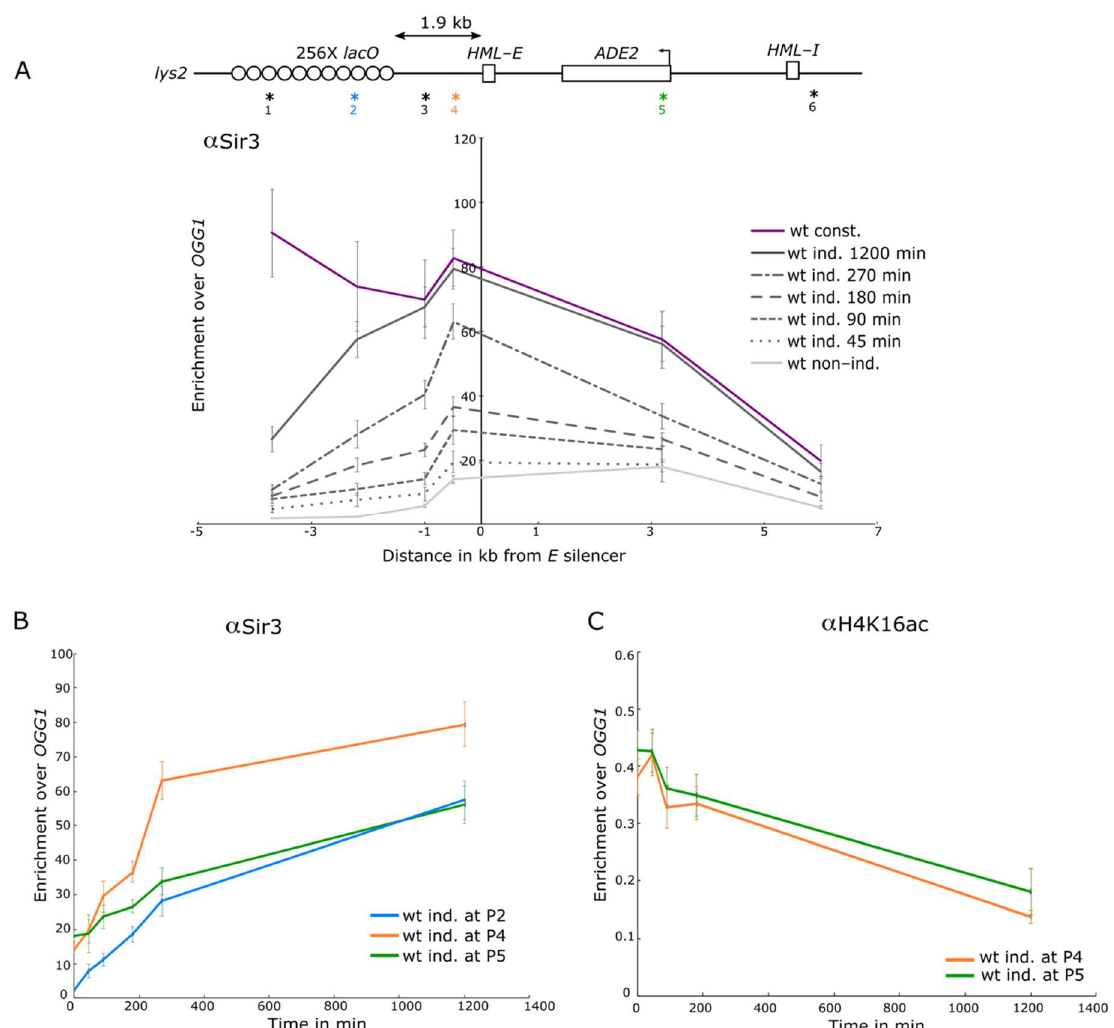
Figure 3. Heterochromatin formation takes place over several cell cycles. ( A ) Sir3 occupancy along the of lys2::lacO E-ADE2-I locus, probed by ChIP-qPCR using an anti-Sir3 antibody developed by us (Ruault et al., 2011), in strains expressing GFP-LacIR either under the constitutive HIS3 promoter (wt const. yAT2059) or under the inducible GALS promoter (wt ind. yAT2078) in raffinose (no induction), or after 45 min, 90 min, 180 min, 270 min, and 1200 min of galactose induction of the GFP-LacIR protein. The data were normalized over OGG1 (shown as mean ± s.e.m.). (P1), (P2), (P3) (P4) amplicons are respectively located at 3.7 kb, 2.2 kb, 1 kb, and 0.5 kb from the left side of the E silencer, and (P5) and (P6) amplicons are located at 3.2 kb and 6 kb from the right side of the E silencer. Amplicon positions are localized on the scheme of the locus with an asterisk and their respective number (see Table S3 for the number of experiments). ( B ) Sir3 enrichment over time at three particular sites of the lacO E-ADE2-I construct inserted at the LYS2 locus: at the lacO (P2), nearby the E silencer (P4), and in the body of ADE2 (P5) obtained by plotting data from Figure 3A. ( C ) H4K16 acetylation occupancy nearby the E silencer (P4) and in the body of ADE2 (P5) in a strain bearing the lys2::lacO E-ADE2-I locus, probed by ChIP-qPCR using an anti-acetyl-histone H4 (Lys16) antibody, in strains expressing GFP-LacIR under the inducible GALS promoter (wt ind. yAT2078) in raffinose (no induction), or after 45 min, 90 min, 180 min, and 1200 min of galactose induction of the GFP-LacIR protein. The data were normalized over OGG1 (shown as mean ± s.e.m.; see Table S3 for the number of experiments). The fastest and highest recruitment was observed at the E silencer (Figures 3A,B and S3A), suggesting that Sir3 and Sir4 are first recruited at this site before spreading on the